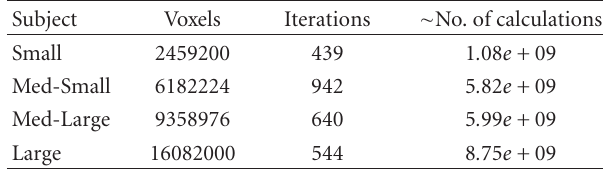
Table 2: Summary of 4 subjects used to analyze computational